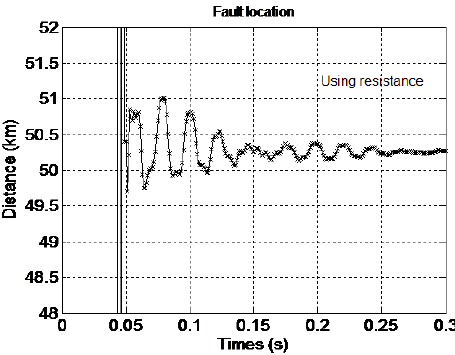
Fig. 8: Fault location as function of time using the re- sistance. can see an instability in the response and the distance is not detected rapidly. We can see that the (cid:28)nal value oscillates around the (cid:28)nal value 50.25 km. The Fault localization time is 0.25 sec.